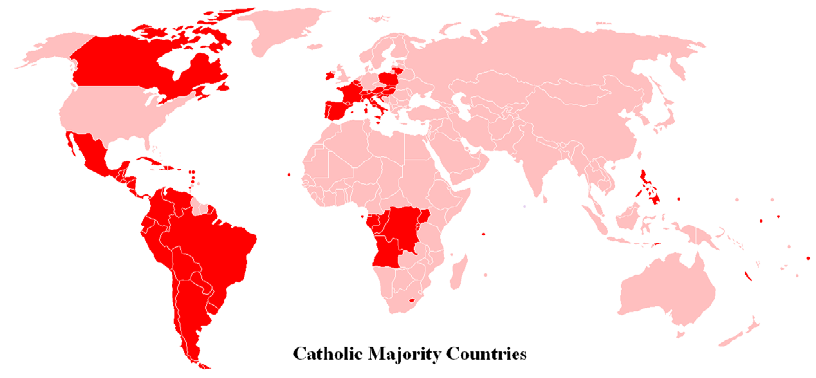
Figure 1. Catholic majority countries. From [30].